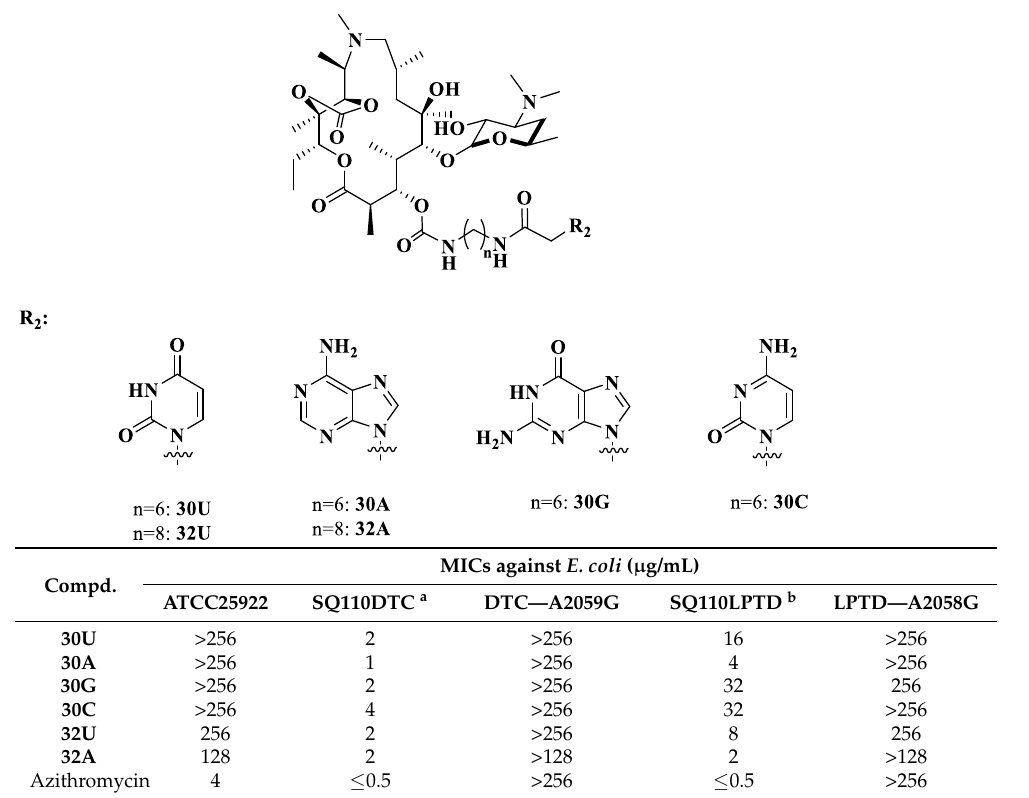
Table 2. In vitro antibacterial activity of 30 and 32 against some standard, engineered and mutant E. coli strains.